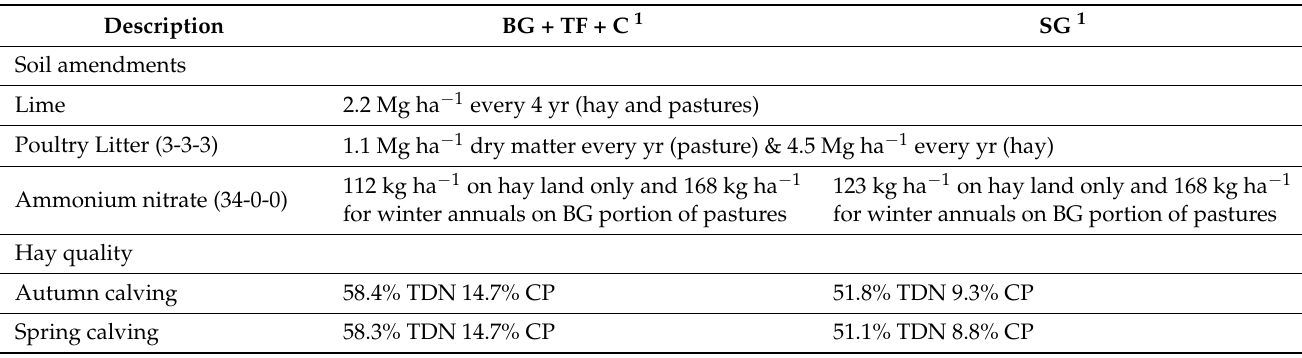
Table 3. Summary of soil amendment and hay quality differences for conventional forage species mix vs. switchgrass on hay land.